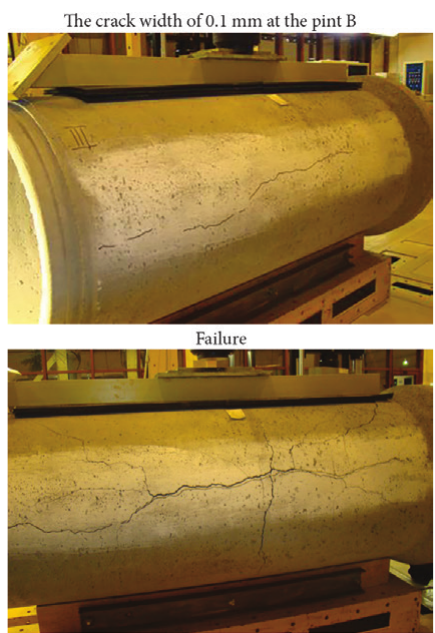
Fig. 7. Pipe during the experimental test Table 2. The basic material characteristics of material model “concrete“ Tangent Modulus, N/mm 2